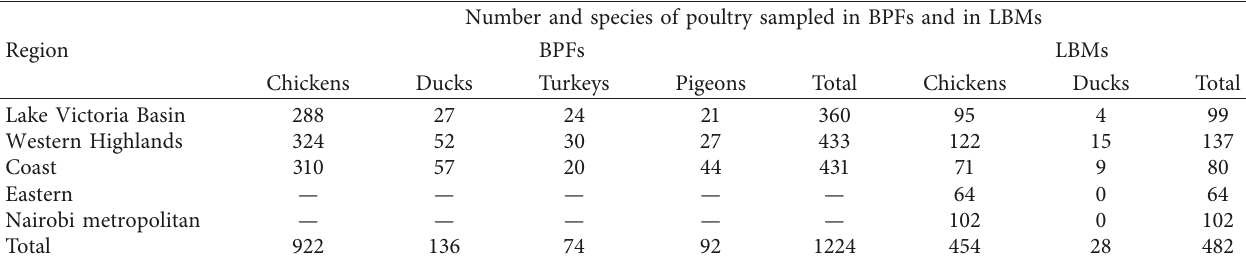
Table 1: Number of birds sampled in live bird markets (LBMs) and backyard poultry farms (BPFs) in different regions of Kenya between 2014 and 2016. Region